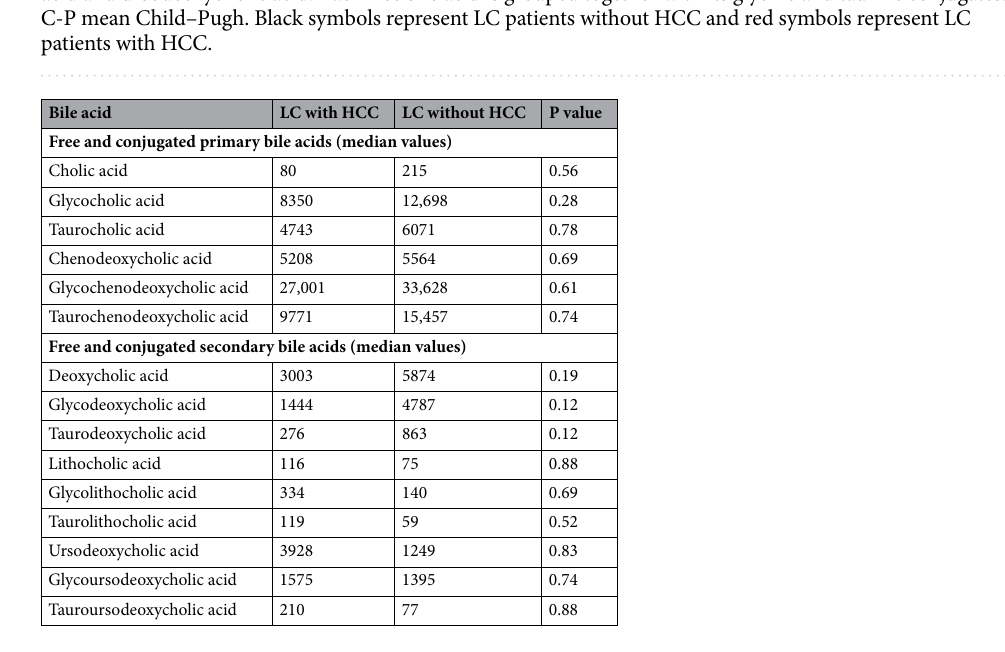
Table 4. Lack of effect of the presence of HCC on 15 primary and secondary bile acids in patients with liver cirrhosis (LC). Analyzed by nonparametric Mann–Whitney U test due to non-Gaussian distribution of data.